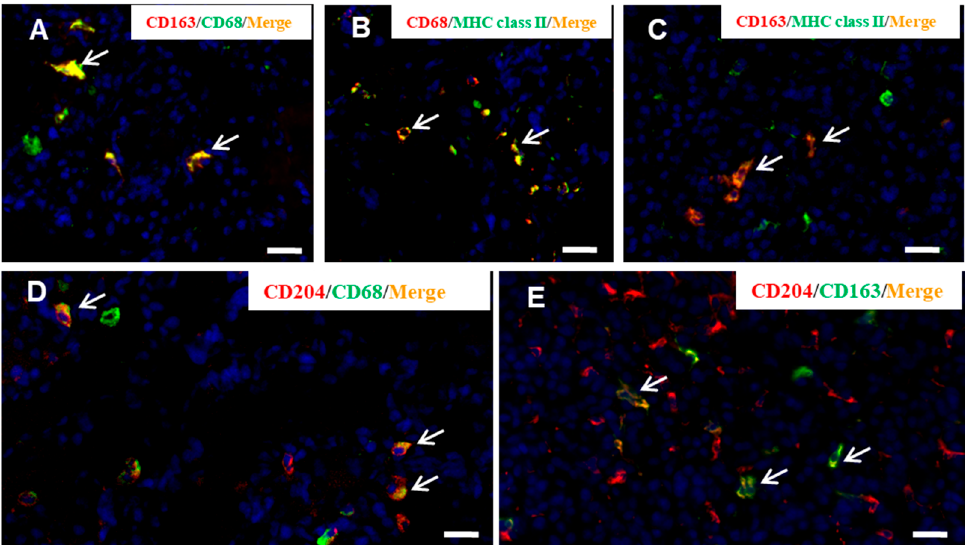
Figure 6. Double immunofluorescence for CD163/CD68 ( A ), CD68/MHC class II ( B ), CD168/MHC class II ( C ), CD68/CD204 ( D ), and CD163/CD204 ( E ) in CDDP-induced renal lesions on day 9. Yellow color (arrows) indicates double-positive reactions. Blue indicates nuclei stained with 4 ′ ,6-diamino-2-phenylindole (DAPI). Bar = 20 µm.